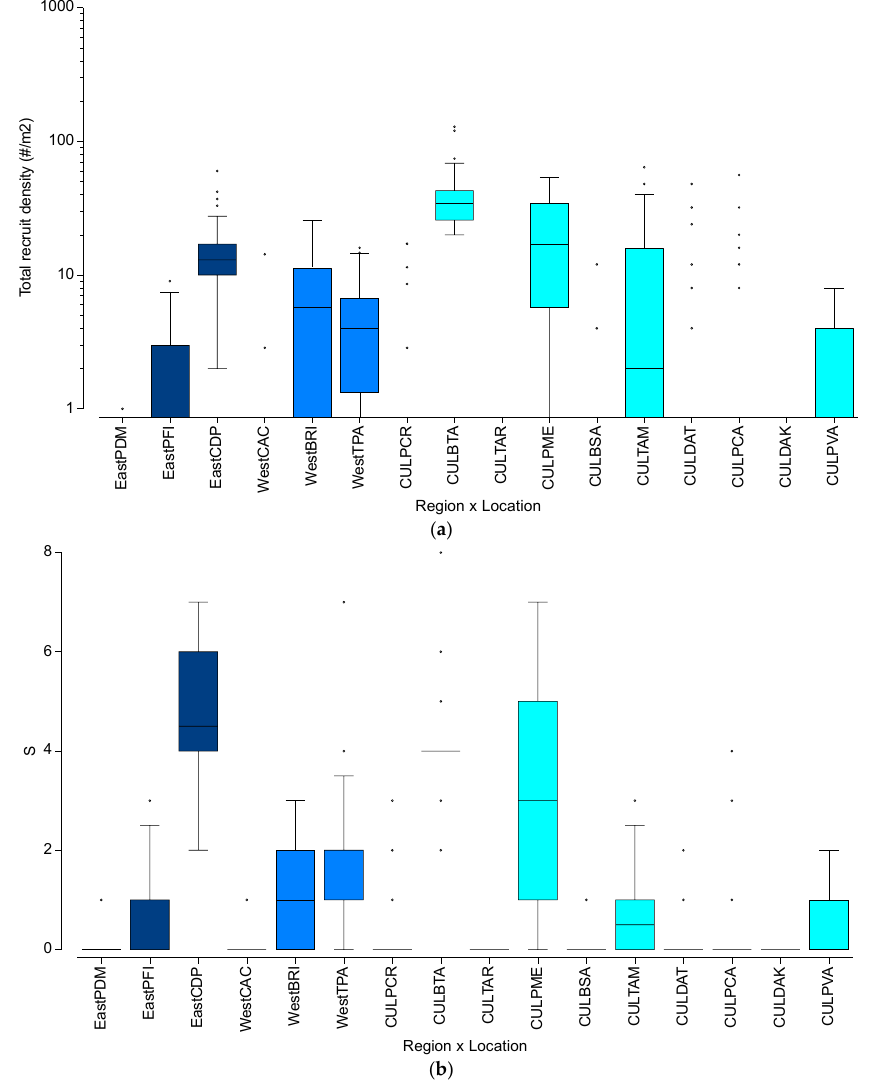
Figure 4. Spatial distribution pattern of: ( a ) Coral recruit density (#/m 2 ); and ( b ) Coral recruit species richness (#/m 2 ) by location. Isolated points show outlier values. Refer to the Methodology for the description of acronyms.